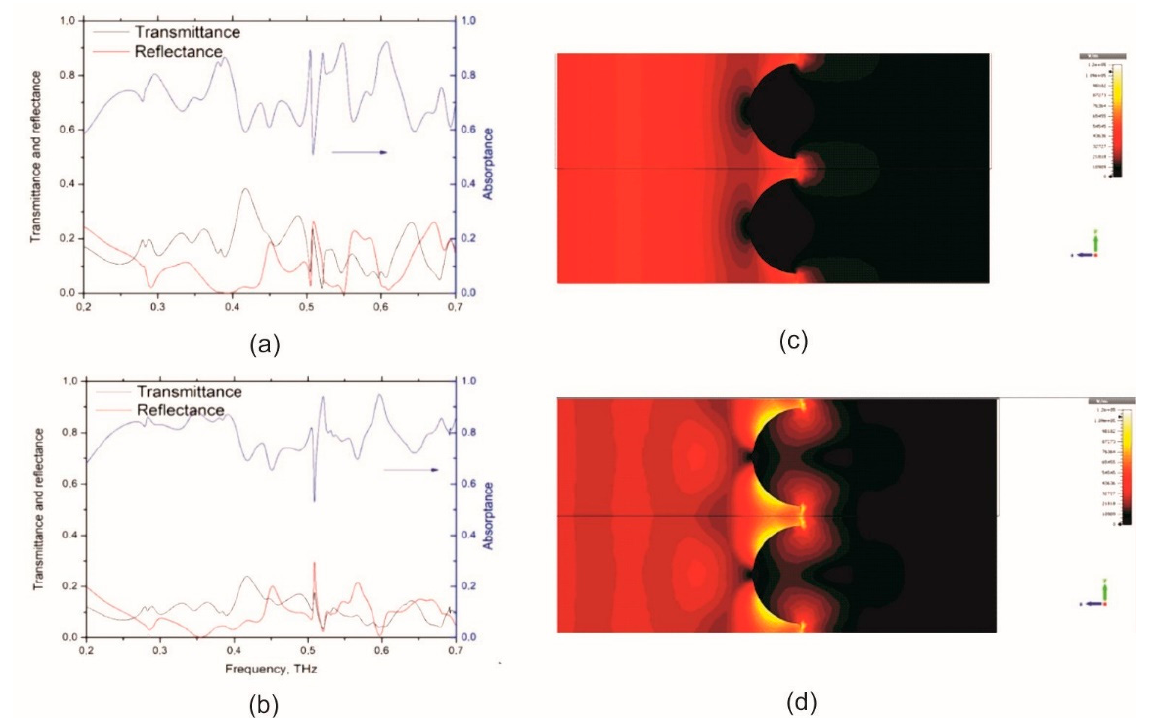
Figure 2. Frequency dependence of the transmittance ( T ), reflectance ( R ) and absorptance ( A ) for ( a ) SiO 2 \ polymer hemispheres \ Ni and ( b ) SiO 2 \ polymer hemispheres \ Ni \ graphene. ( c ) Distribution of the electric field amplitude at a frequency of 0.6 THz at the surface of the structure SiO 2 \ polymer hemispheres \ Ni; ( d ) the same for the SiO 2 \ polymer hemispheres \ Ni \ graphene. The following parameters were used in the calculations: the diameter and period of the hemispheres on the SiO 2 surface are 440 µ m and 600 µ m, respectively, the sheet conductance of graphene is 1.1 mS, the nickel sheet conductance is 3